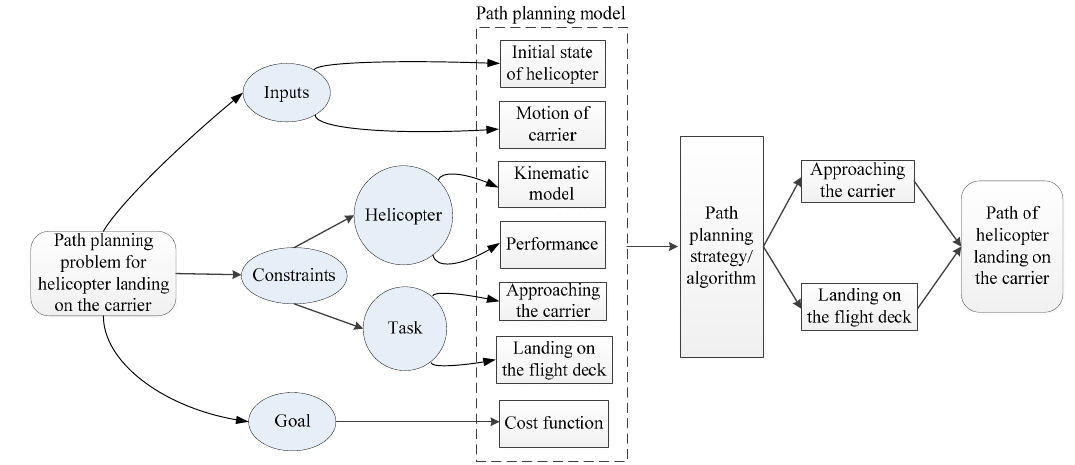
Figure 2. Conceptual model of the problem.